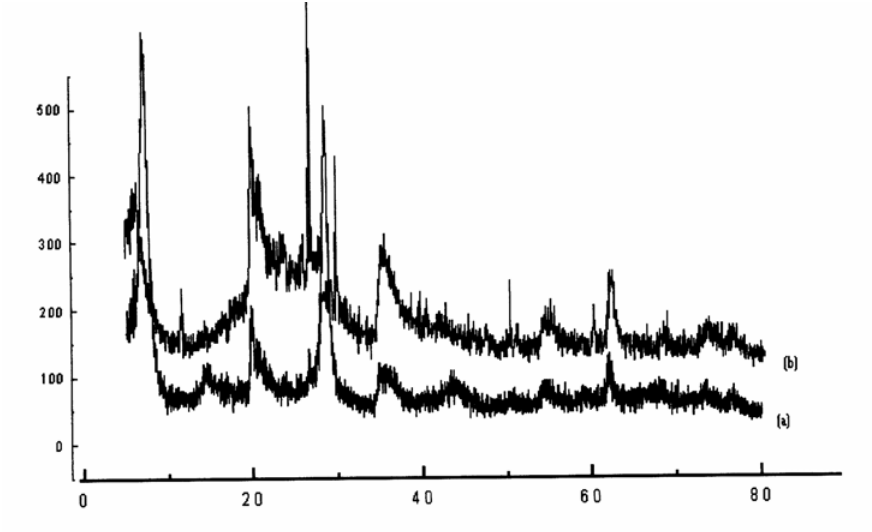
Figure 1. X-ray powder Diffraction of (a) “Raw-Maghnite” and (b) “H-Maghnite0.25M” Table 2. XRD characteristic of Raw-Maghnite and H-Maghnite0.25M.